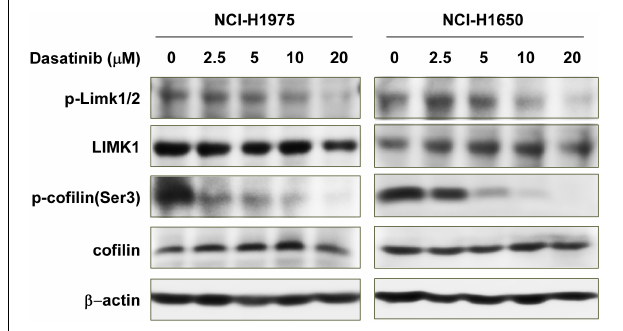
FIGURE 5 | Dasatinib inactivates LIMK1-related signaling pathways. Treatment with dasatinib downregulates p-LIMK (Thr 508/505) and